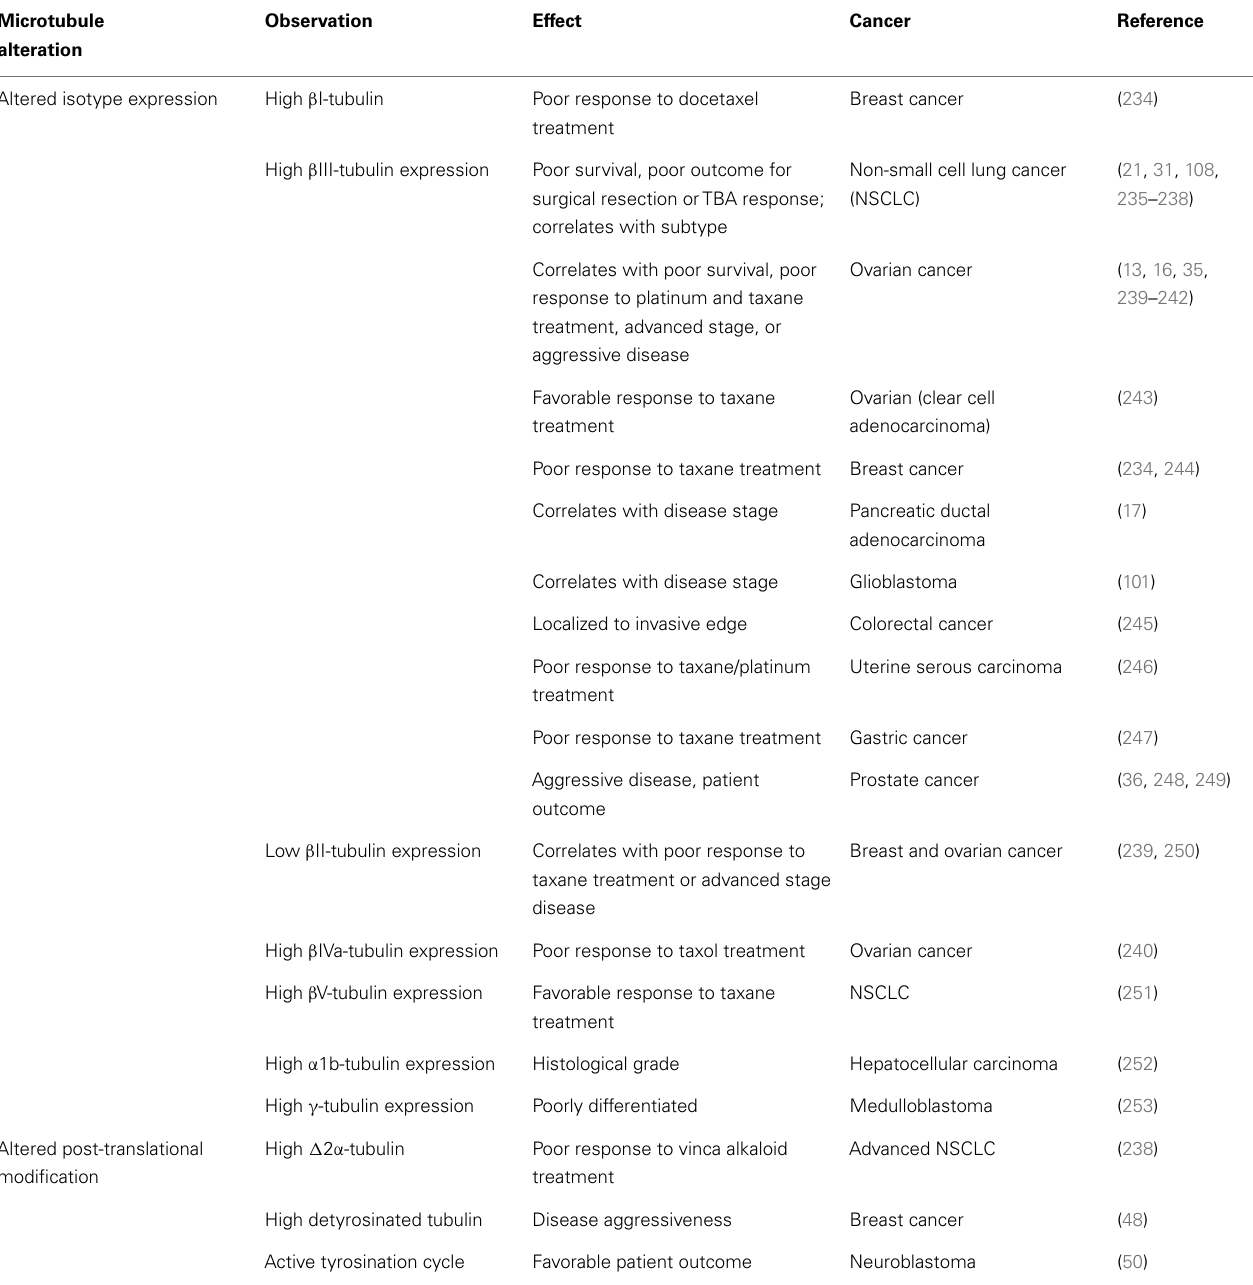
Table 2 | Clinical studies of tubulin alterations in cancer